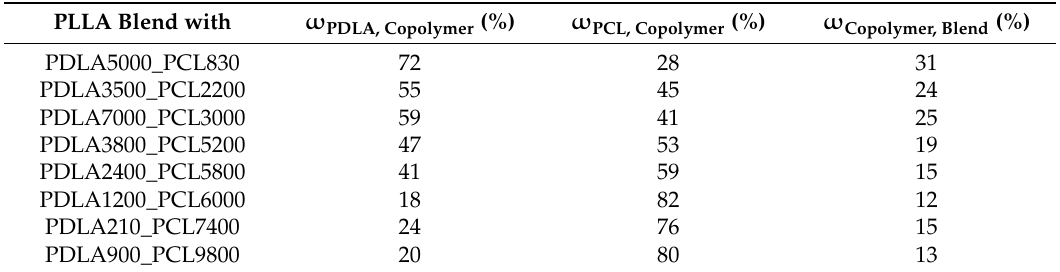
Table 3. Data of thermogravimetric analysis of the PDLA-PCL diblock copolymers. PLLA Blend with